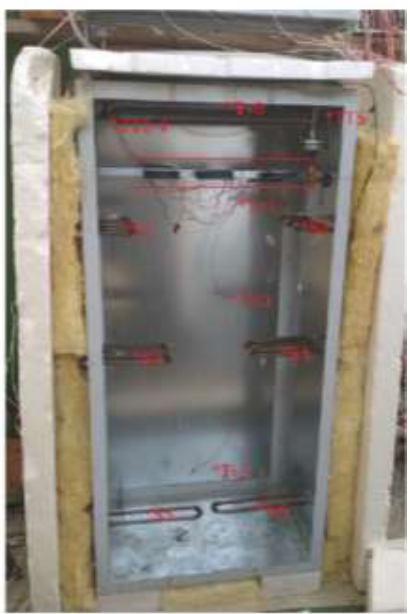
Fig. 8. Experimental equipment in laboratory – part with evaporator: Tv1 – temperature measurement at the top of the box, TT2-4 –temperature measurement on evaporator tubes, Tv2 –temperature measurement in the central part of the